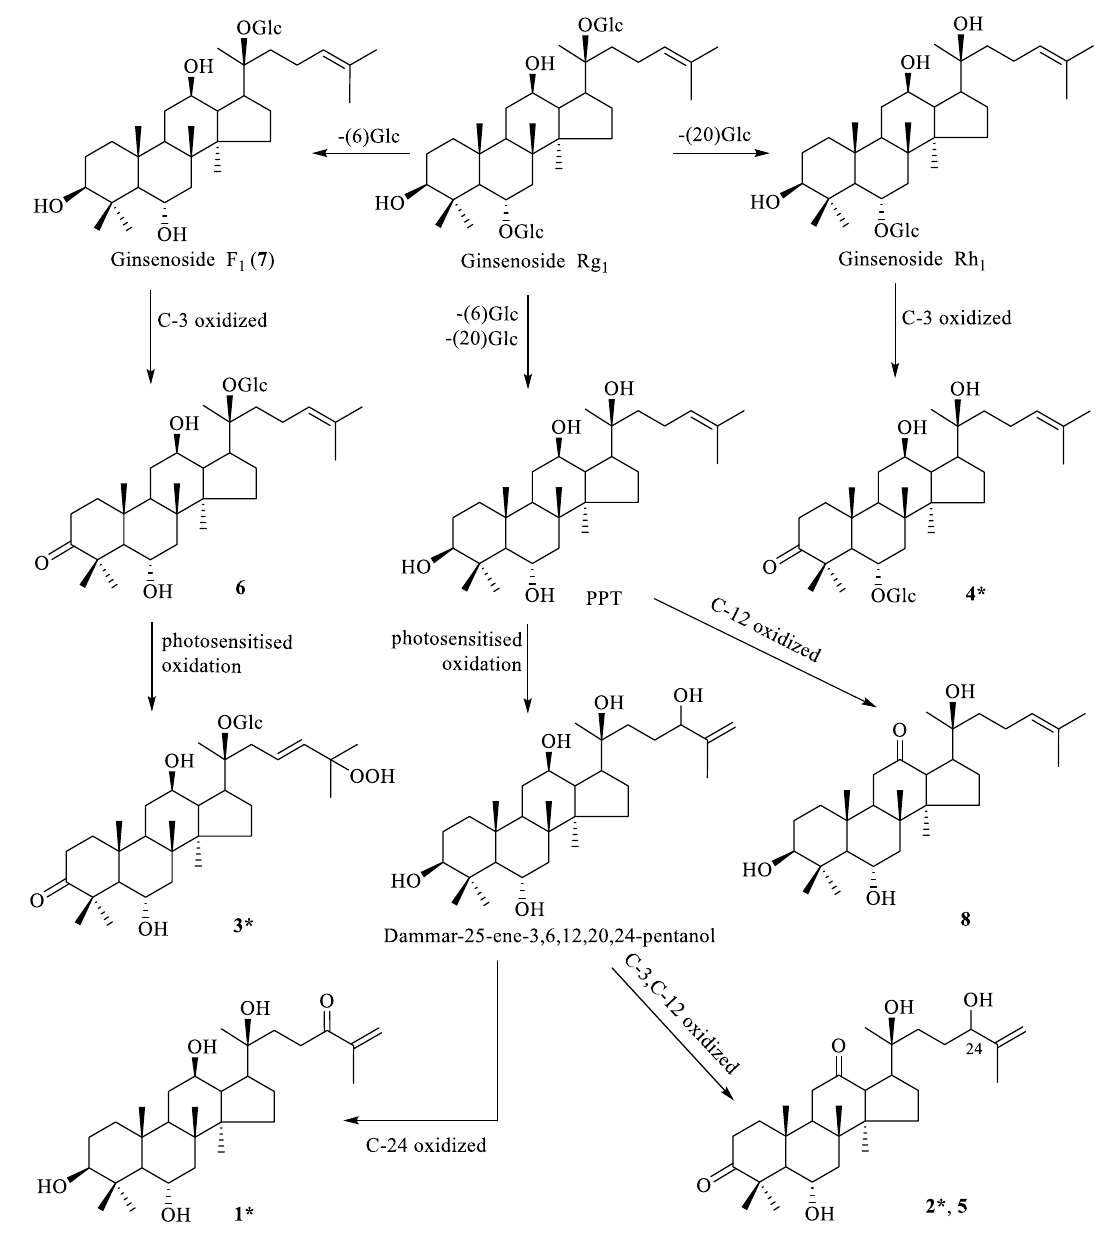
Fig. 3 The possible transformation pathway of 1 – 8 from ginsenoside Rg